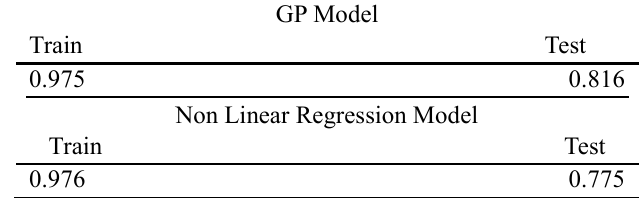
R-square value for GP and Non Linear Regression